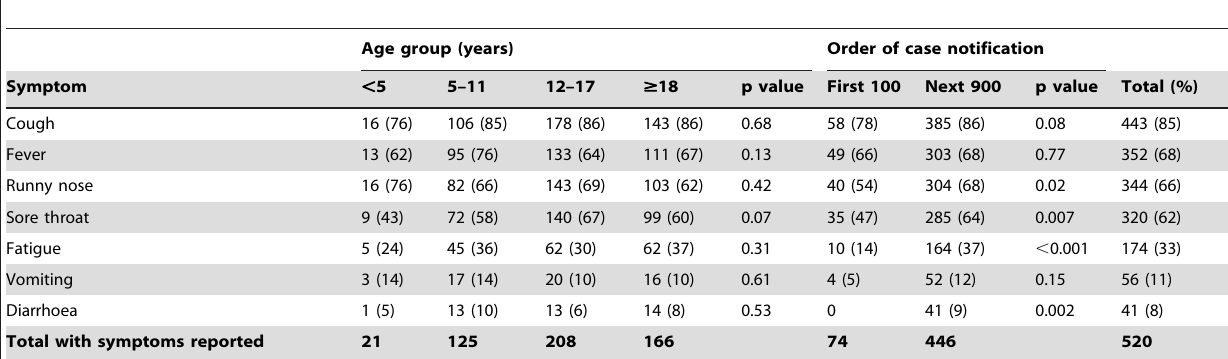
Table 1. Reported symptoms for 520 of first 1,000 confirmed influenza A(H1N1)pdm09 cases with data by age group and order of case notification, Victoria,